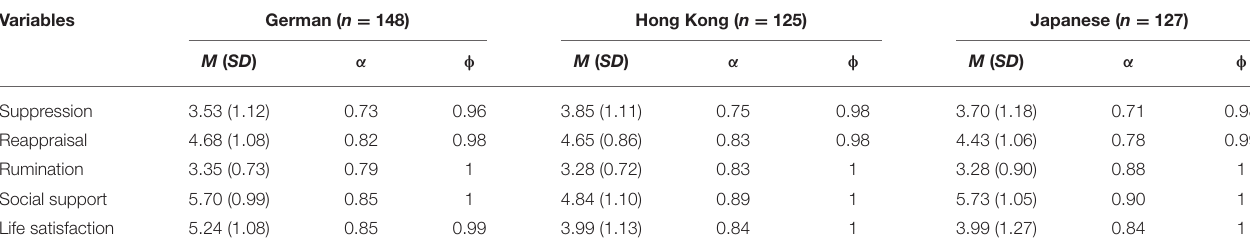
TABLE 1 | Descriptive statistics and congruence coefficients for study variables by culture.